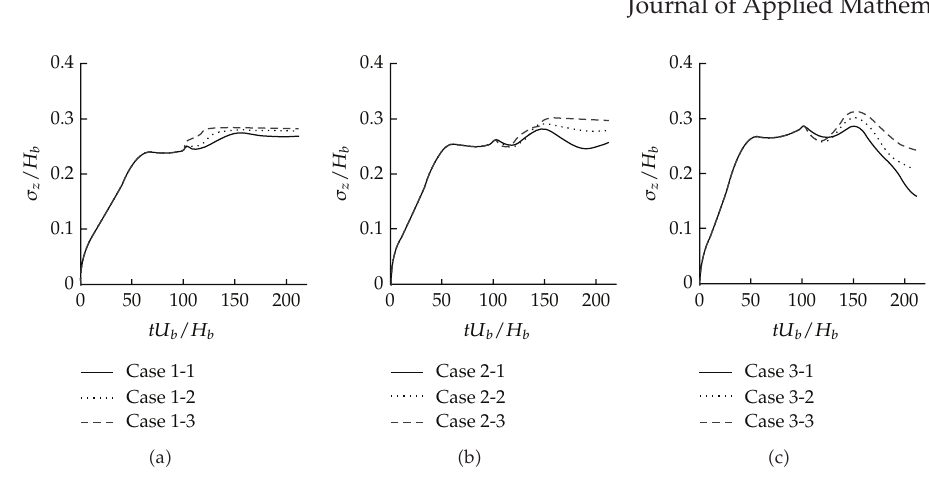
Figure 11: Time lines of concentration dispersion width of vertical direction (cid:3) a (cid:4) Case 1, (cid:3) b (cid:4) Case 2, and (cid:3) c (cid:4) Case